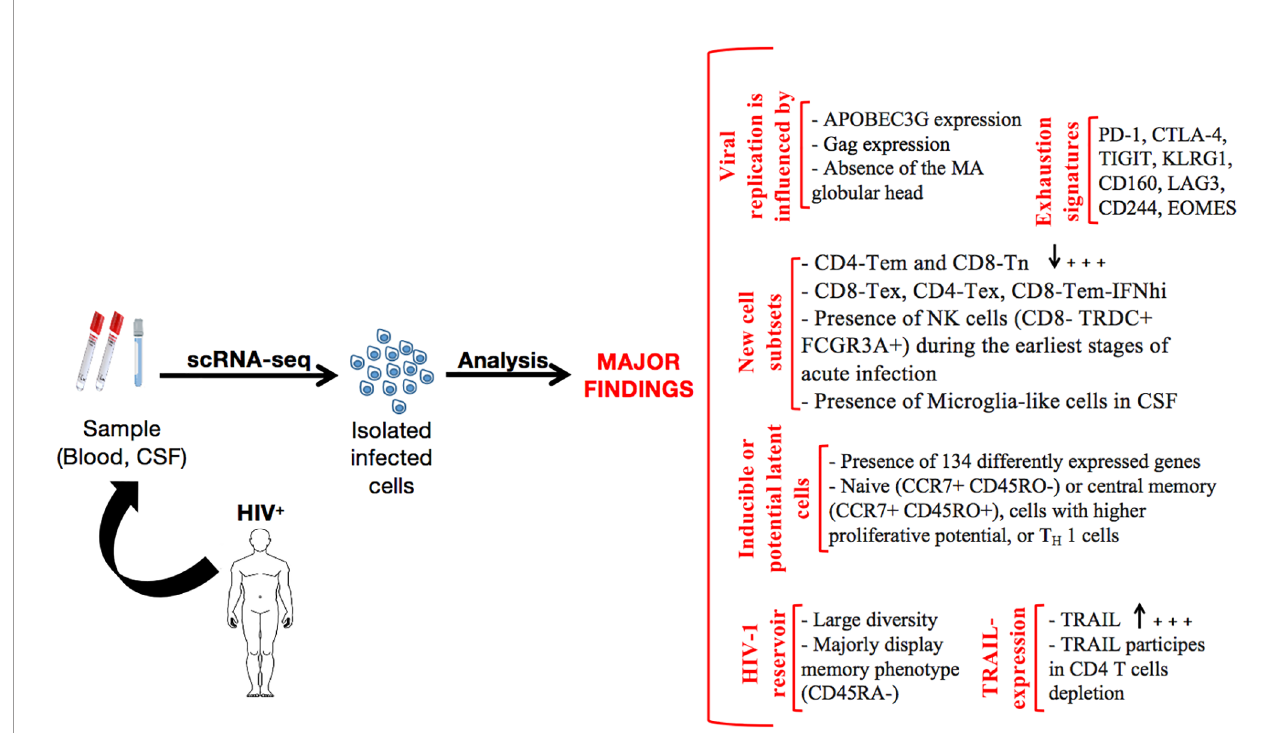
FIGURE 2 | Summary of the major fi ndings resulting from scRNA-seq application in HIV